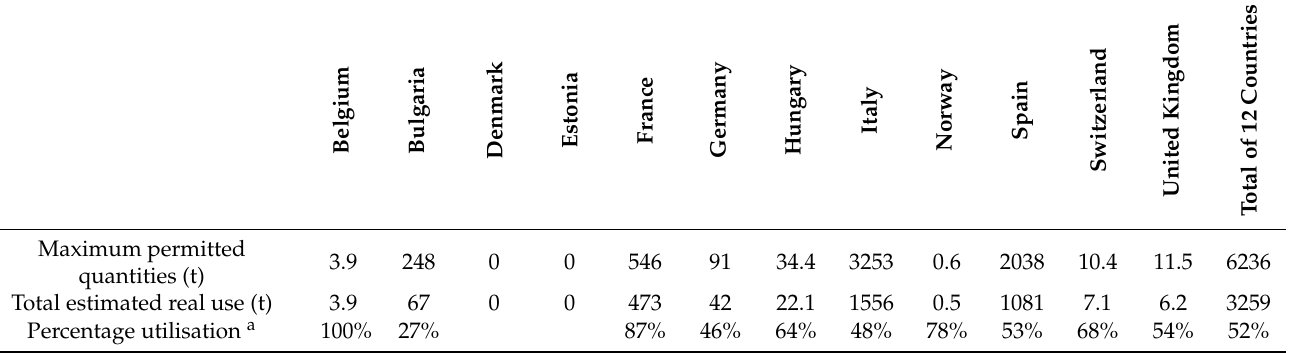
Table 4. Maximum permitted amounts of copper (t y − 1 ), total estimated real use (t y − 1 ), and percentage utilization in organic farming in the 12 surveyed European